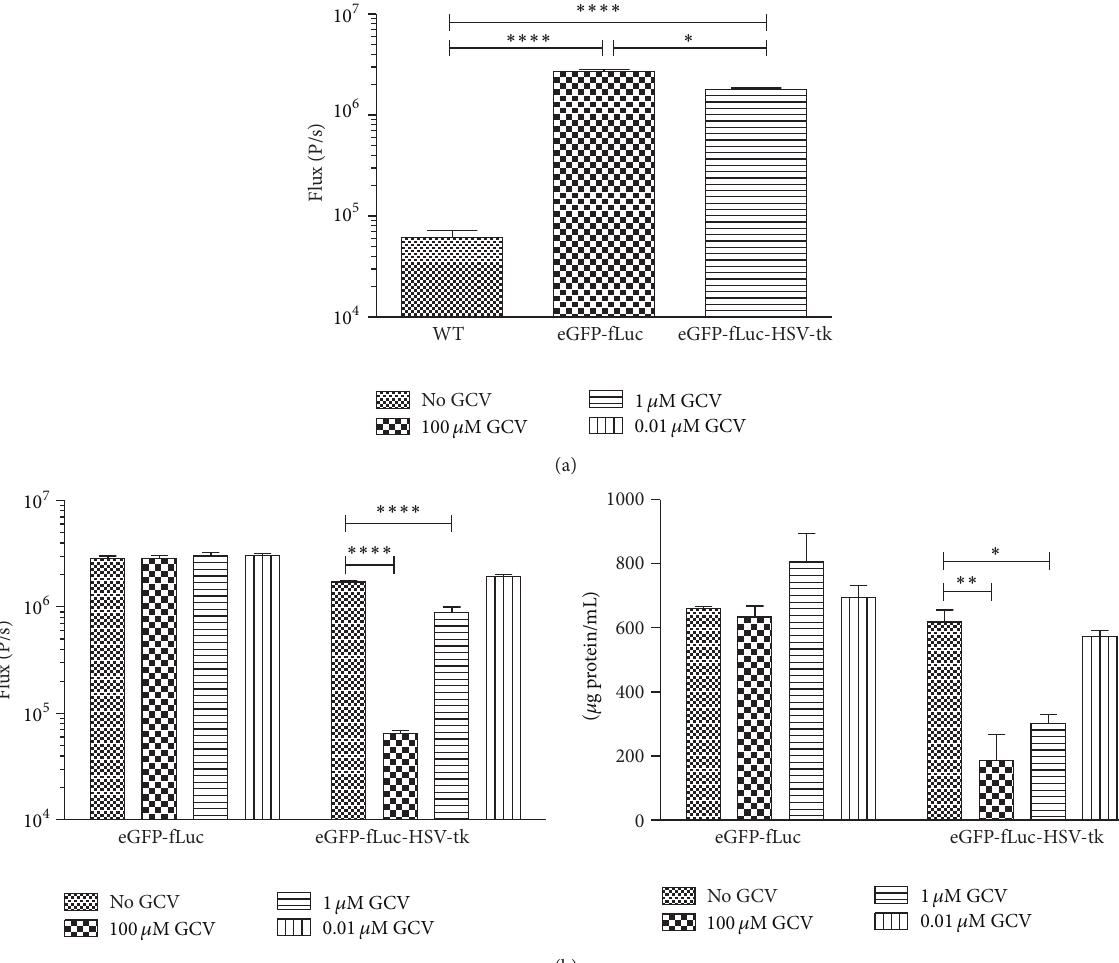
Figure 2: In vitro validation of hMultistem transduction. (a) Assessment of firefly luciferase (fLuc) expression via BLI showed a significant difference between transduced (eGFP-fLuc as well as eGFP-fLuc-HSV-tk) and wt hMultistem. (b) GCV killing experiment for validation of HSV-tk expression. Left: BLI signal was significantly decreased in eGFP-fLuc-HSV-tk expressing cells but not in eGFP-fLuc expressing control cells for all GCV concentrations compared to cells without GCV treatment. Right: the BCA protein assay confirmed BLI results and showed a dose-dependent cell killing in eGFP-fLuc-HSV-tk expressing cells but not in eGFP-fLuc expressing cells. Levels of significance are expressed as ∗ 𝑝 < 0.05 , ∗∗ 𝑝 < 0.01 , ∗∗∗ 𝑝 < 0.001 , and ∗∗∗∗ 𝑝 < 0.0001